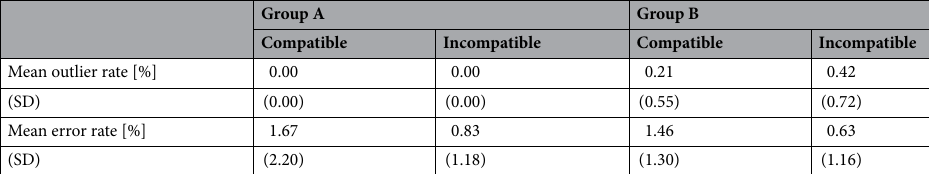
Table 2. Mean outlier and error rates in the Joint condition of Groups A and B in Experiment 2. Neither group shows significant differences in the mean outlier rates between compatible and incompatible trials. In Group A, the mean error rates between compatible and incompatible trials do not differ significantly, whereas that in Group B is significantly greater in the compatible trials than in the incompatible